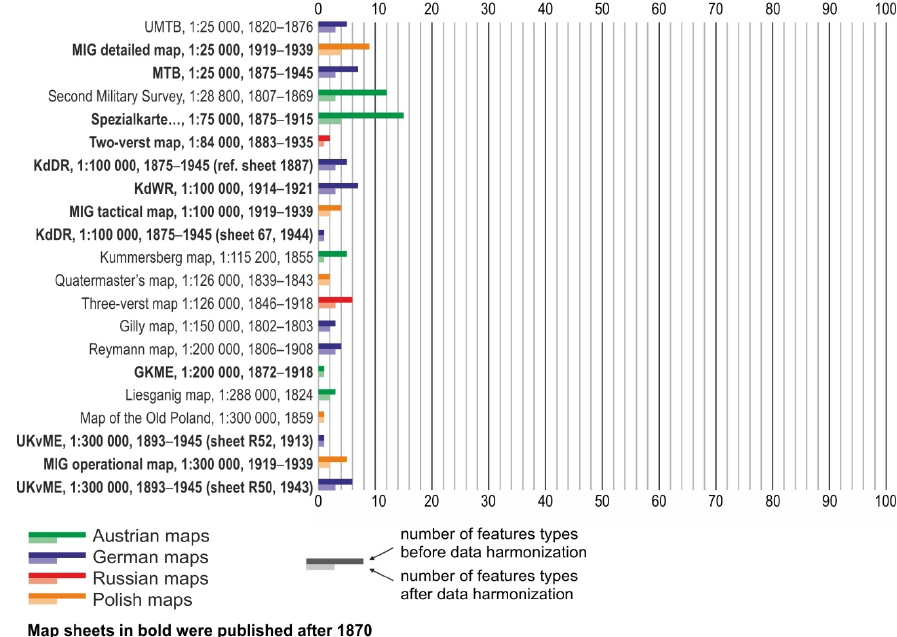
Fig. 2. Number of feature types on different maps’ key to symbols among “water network” feature class category (before and after